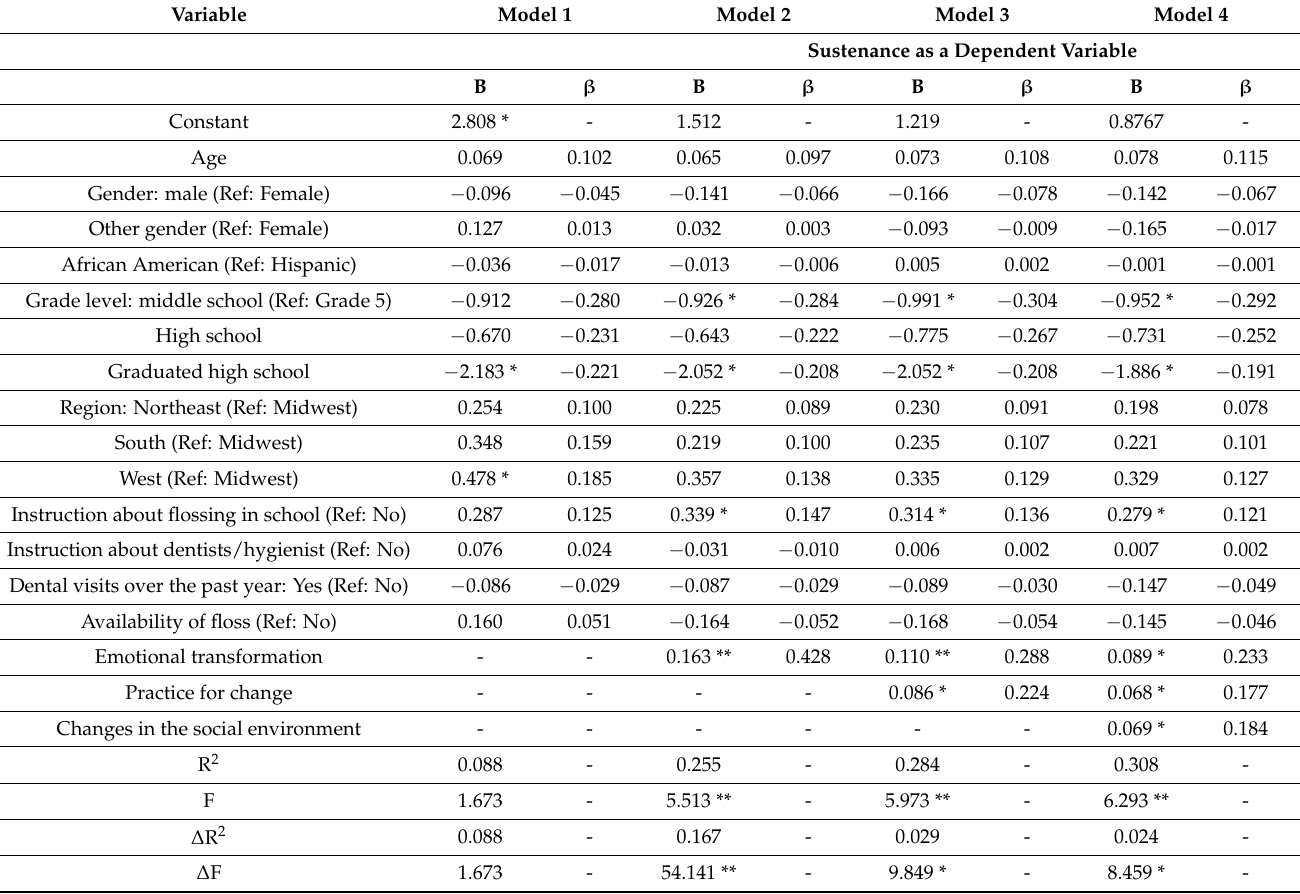
Table 7. Hierarchical multiple regression to predict the likelihood of sustaining flossing among participants who already initiated flossing (N = 258).